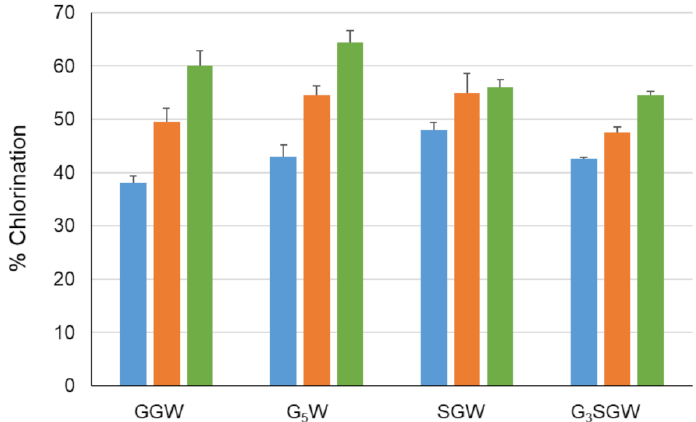
Figure 5. Peptide chlorination using WT PyrH (blue), PyrH‑dASQV (orange) and PyrH‑Q160N (green) for indicated peptides. Values represent average ± SD ( n =